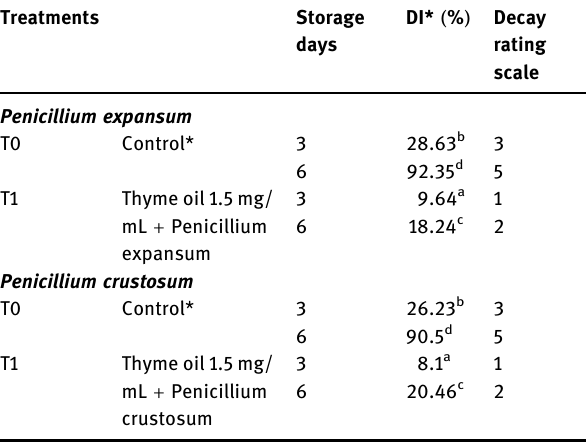
Table 8: Physiochemical properties of thyme EO Parameters